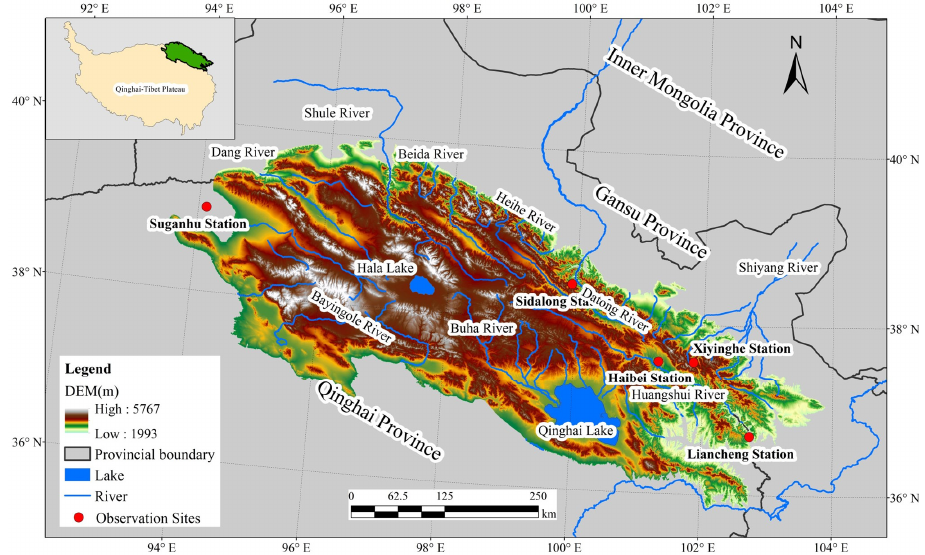
Figure 1. Geographical location of the Qilian Mountains.